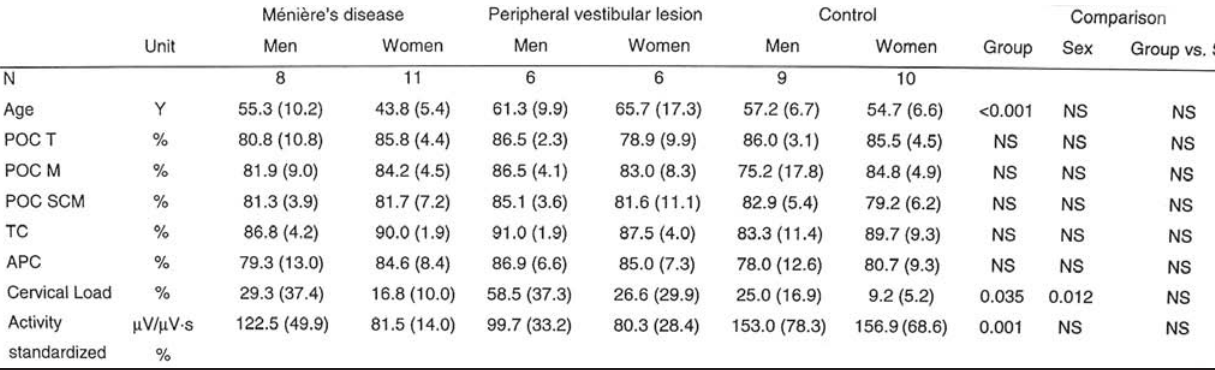
POC: percentage overlapping coefficient (index of left-right muscular symmetry); T: temporalis anterior muscle; M: masseter muscle; SCM: sternocleidomastoid muscle; TC: torque coefficient (potential lateral displacing component); APC: anteroposterior coefficient (relative activities of masseter and temporalis muscles); Cervical load: contraction of SCM during MVC as % of standardization potentials; Comparison: p values from a 2-way factorial analysis of variance (for age) or covariance (for all other variables; age as covariate): factor 1: group (Ménière’s disease, peripheral vestibular lesion, control); factor 2: sex; interaction dental group vs. sex) NS, non-significant